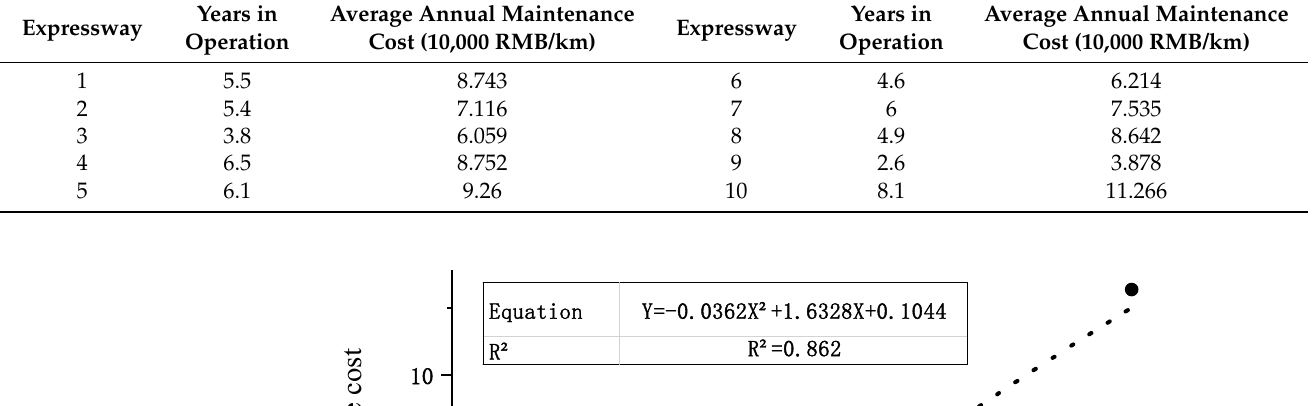
Table 4. The number of years in operation and the average annual maintenance fee.